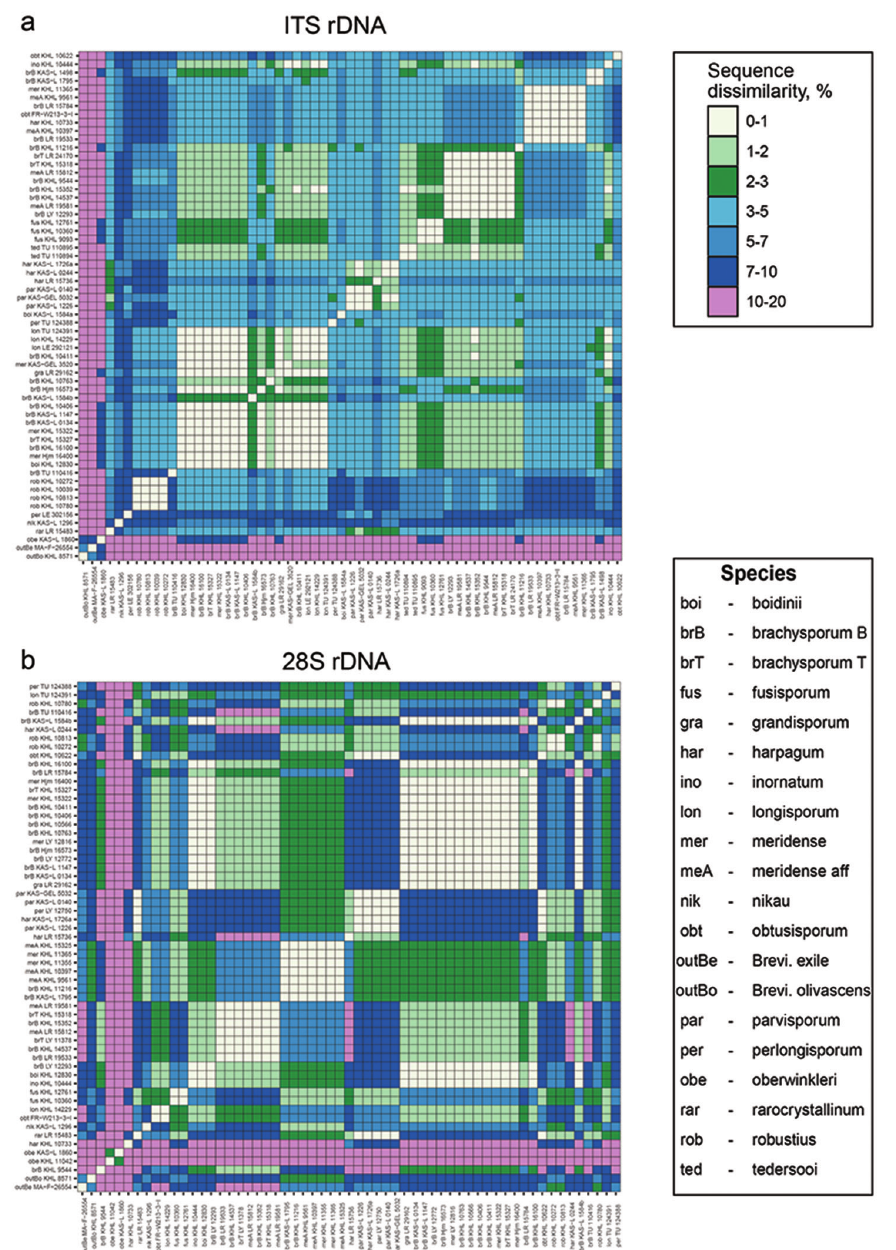
Figure 1. Raw pairwise dissimilarities (proportion of the differing sites, %) between Subulicystidium sequences of ( a ) ITS and ( b ) 28S region. Three-letter code before each specimen’s number corresponds to a species epithet as explained in the